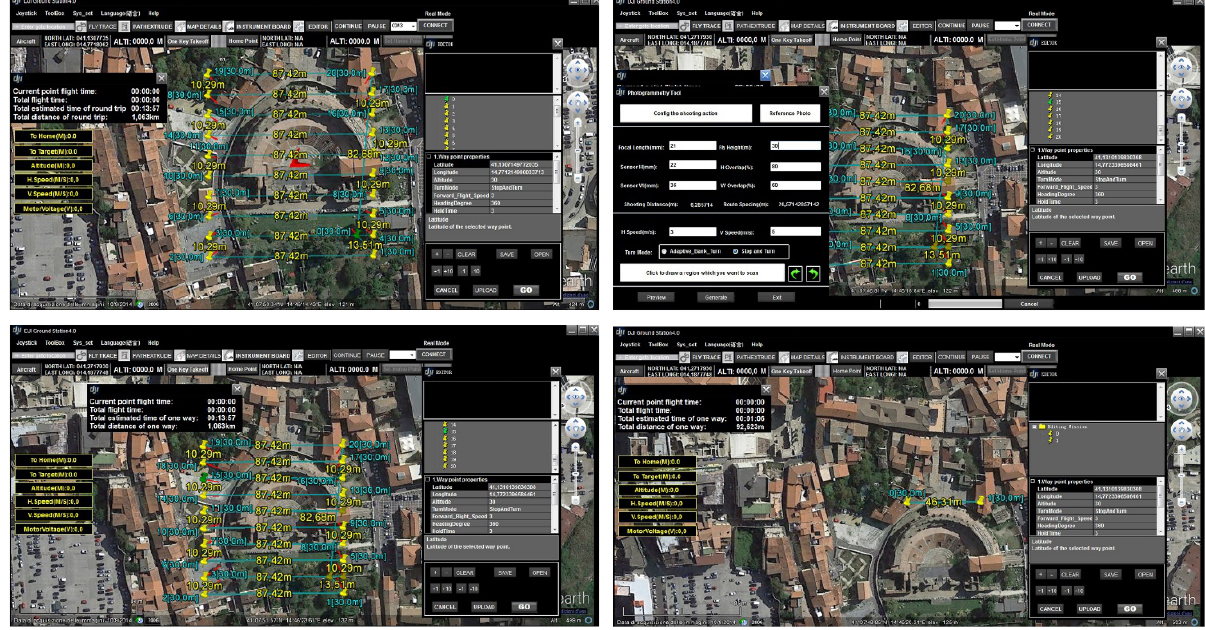
Figur e 4: Setting the Flight Plan Using DJI Ground Station 4.0 Software.